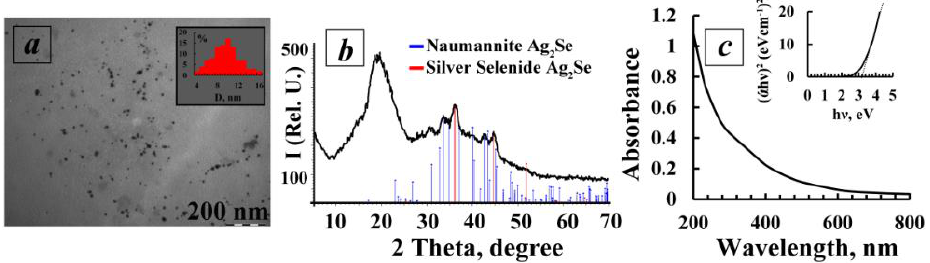
Figure 2. ( a )—Microphotograph and particle size distribution (inset) of Ag 2 Se nanoparticles in AG polysaccharide matrix; ( b )—diffractogram of Ag 2 Se-AG nanocomposite (4%w Ag 2 Se); ( c )—absorption spectrum of 0.1% of Ag 2 Se-AG nanocomposite (4%w Ag 2 Se) water solution and its Tauc plot of ( α h ν ) 2 vs. (h ν ) (inset) .